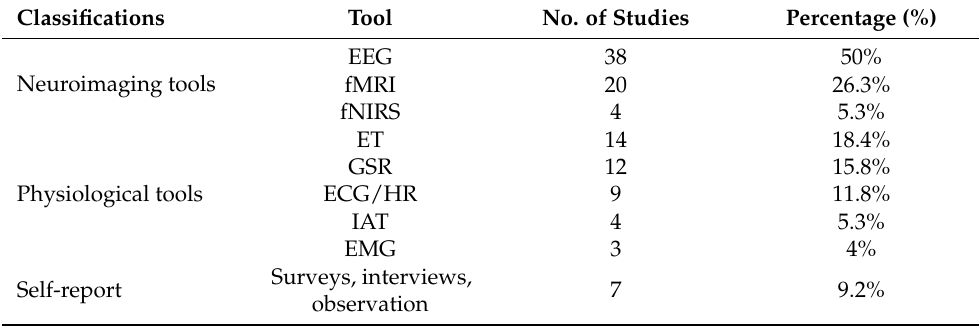
Table 1. Classifications of neuroimaging and physiological tools used in advertising research.